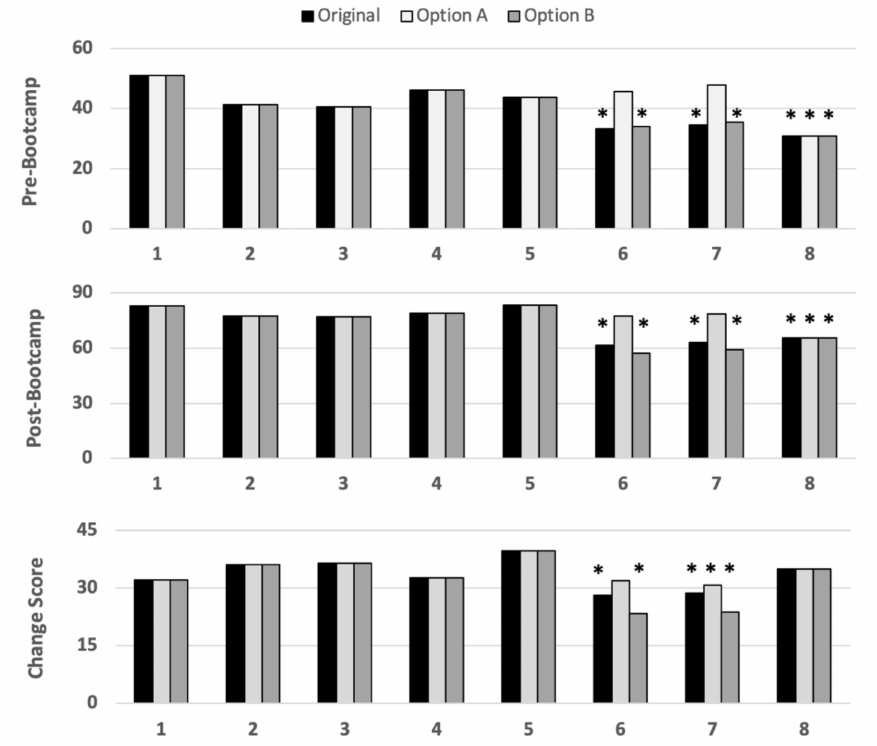
Figure 2. Subplots of mean scores by cohort using original and alternative WST-Q scoring. Note: asterisks indicate cohorts that were significantly lower than the remaining cohorts ( p < 0.05) when using the original (black), option A (white), and option B (grey) scoring scales; WST-Q = Wheelchair Skills Test